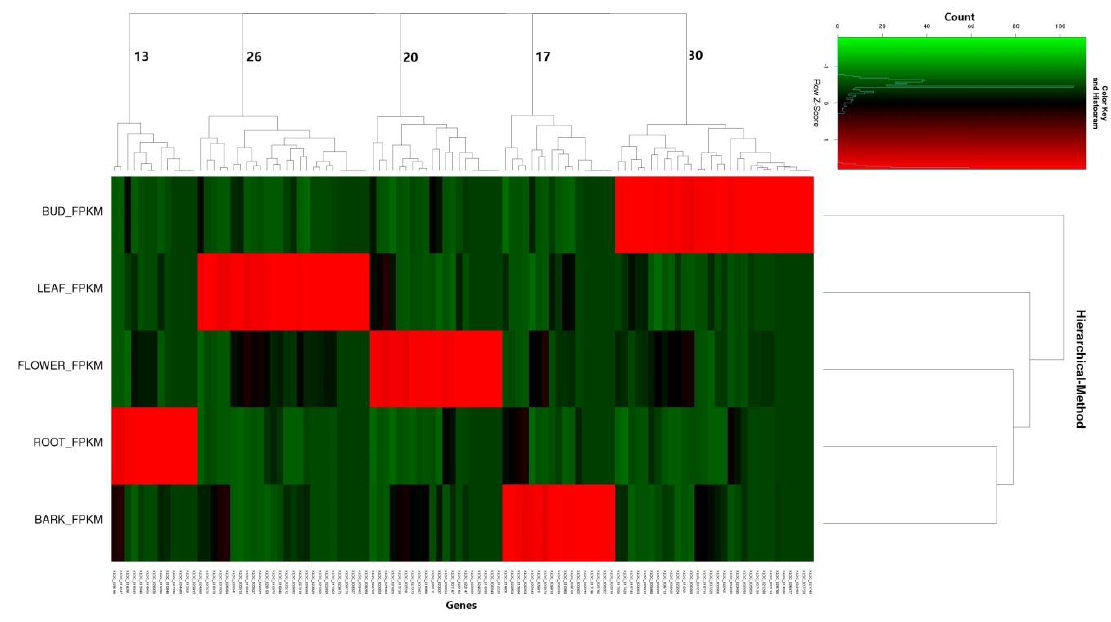
Figure 8. Tissue specificity of lncRNAs from winter bud, leaf, male flower, root, and bark of mulberry.